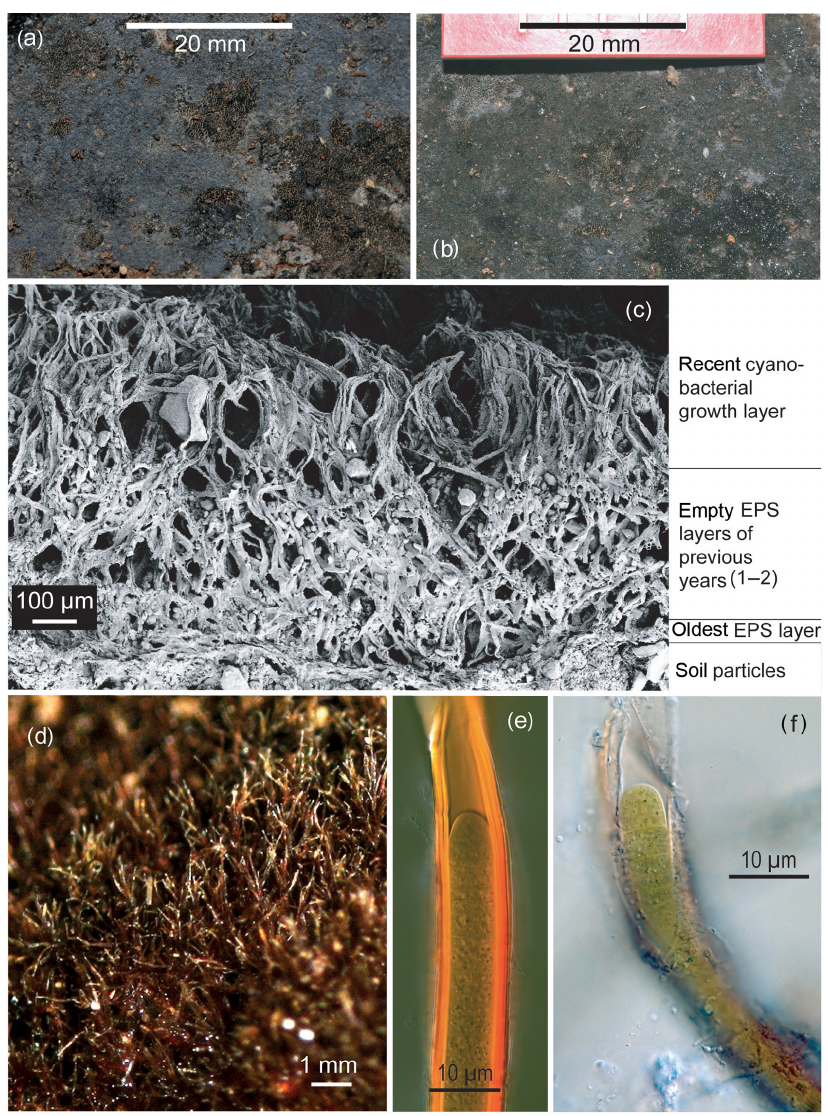
Figure 2. (a) Close-up of the dry Boodjamulla biocrust at the measuring site, grey areas are dominated by the cyanobacterium Scytonema sp., dark-brownish areas dominated by Symplocastrum purpurascens . (b) Same as in (a) , but after rehydration. (c) Gross fraction of the S. purpurascens -dominated biocrust and its stratification (EPS means extracellular polysaccharide sheath; LT-SEM). (d) In situ top view of the S. purpurascens biocrust. (e) Filament with red sheath from the top of the biocrust and (f) from beneath with a more-or-less colourless